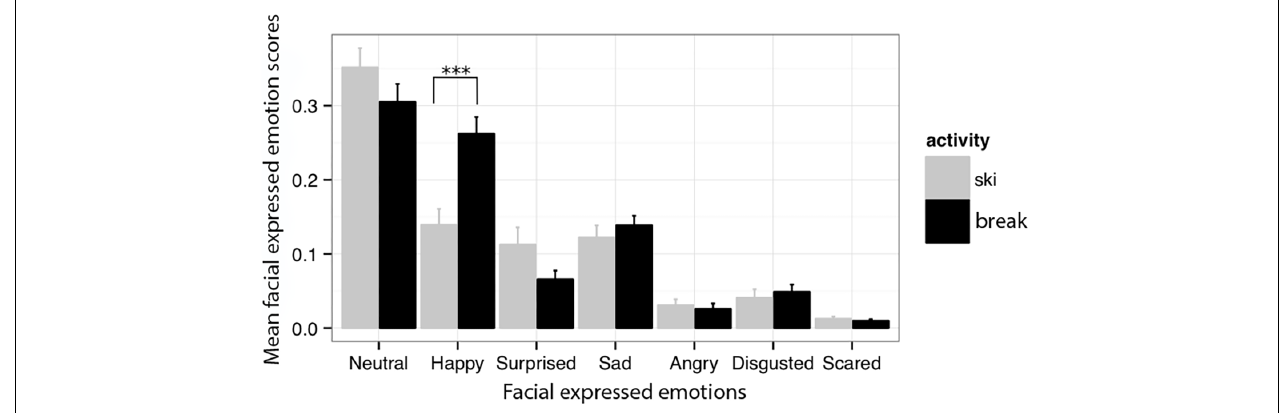
FIGURE 3 | Mean facial expressed emotions during skiing (gray) and breaks (black) across the six facial expressed emotions plus the generated neutral state. ∗∗∗ p < 0.001.